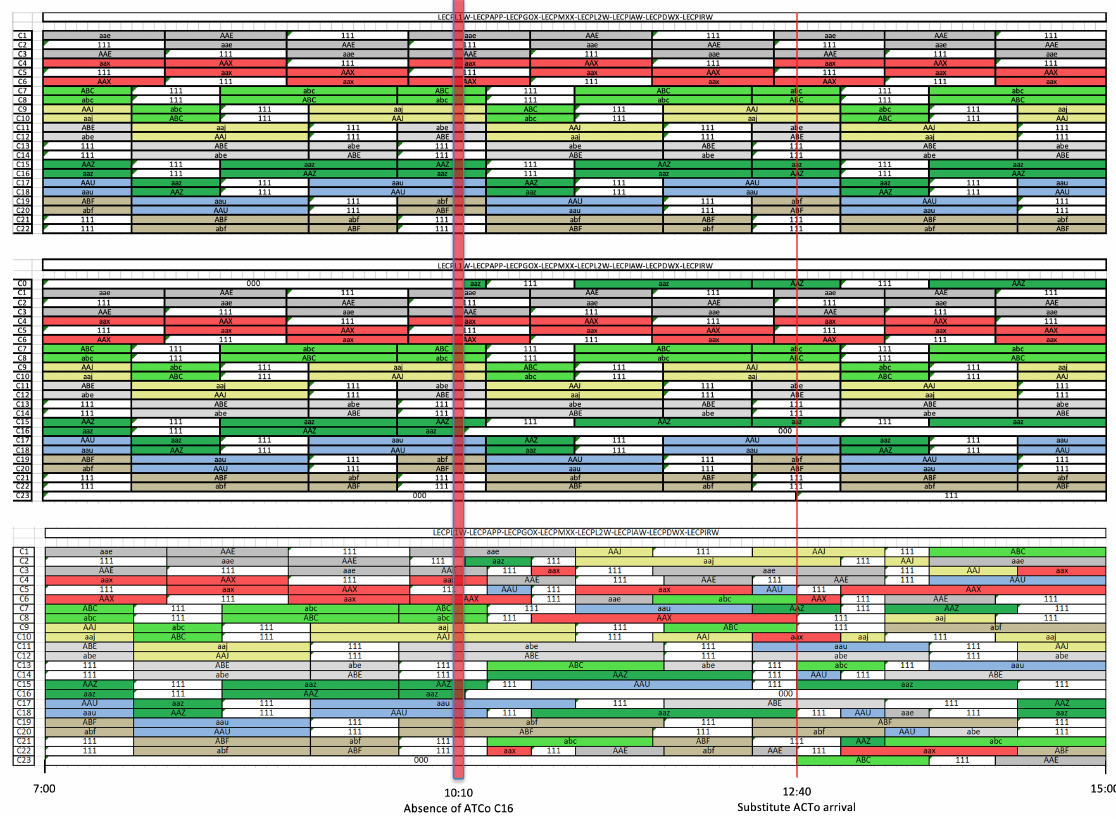
Figure 18. Solution before the incident, initial solution, and solution for Instance